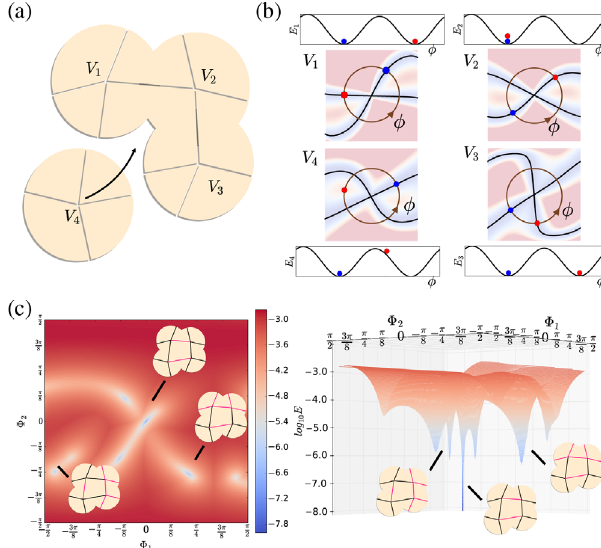
FIG. 3. Loops of vertices give rise to a glassy landscape. (a) – (b) When a chain of vertices is closed by adding a final vertex, the resulting branches are no longer of zero energy. For example, if vertices V 1 , V 2 , V 3 are at one of their two zero-energy states (red dots), V 4 ’ s folding state is constrained since the folding states of creases V 1 − V 4 and V 3 − V 4 are already set. The resulting energy for V 4 is generically not zero (red dot for V 4 ). We computed the energy in the four-dimensional linearized null space at a fixed norm ∥ ⃗ ρ ∥ . (c) The heatmap and surface plot show a two-dimensional projection onto the two top eigenvectors Φ 1 , Φ 2 in the linearized null